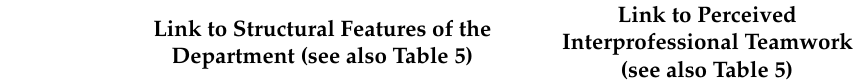
Table 3. Overview of team-related process features and their facilitating factors and barriers, as well as their links to structural features of the department and to perceived quality of interprofessional